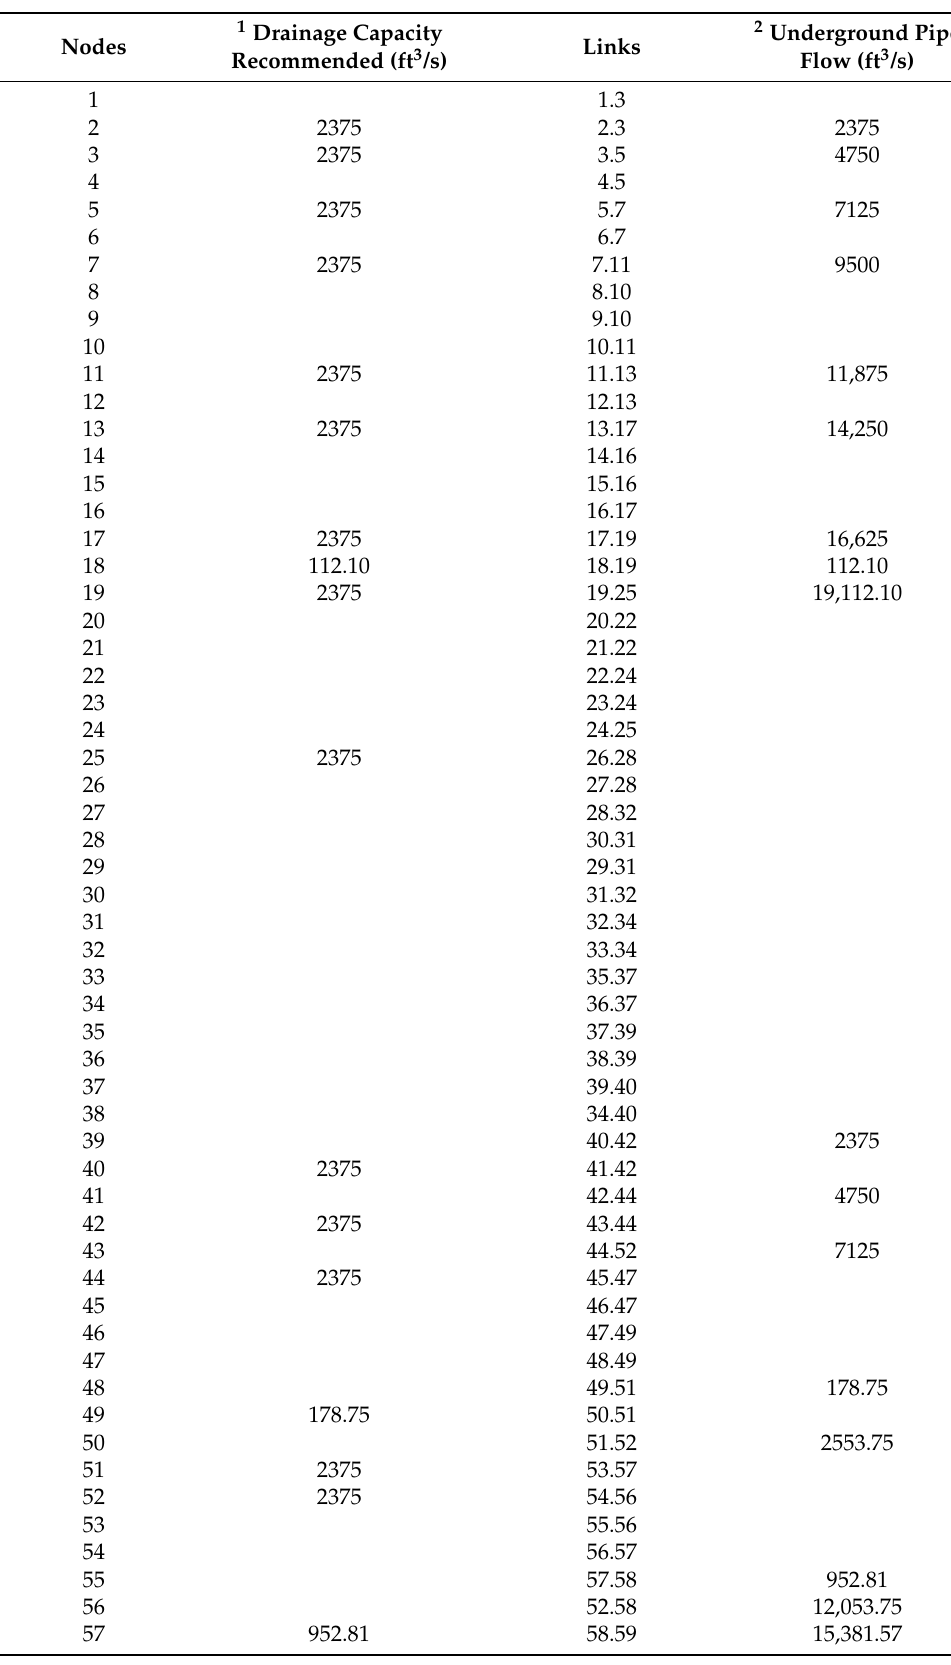
Table 5. Optimization values for Leadville. CO watershed (analysis for the 100-year storm).